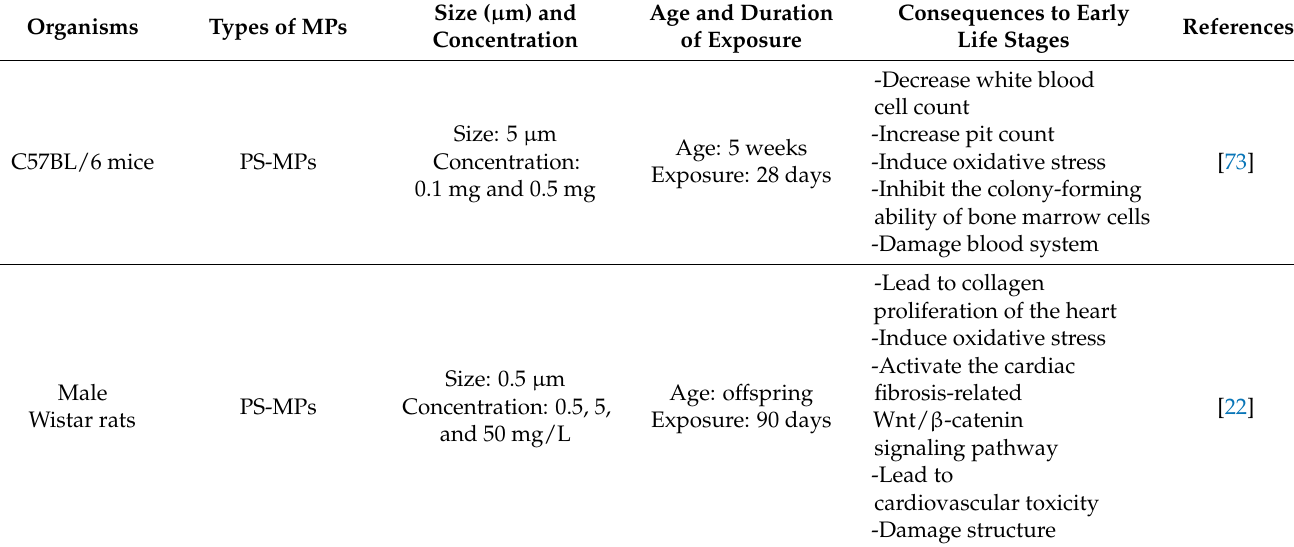
Table 5. Summary of the effects of MPs exposure on the circulatory system during the early develop- mental